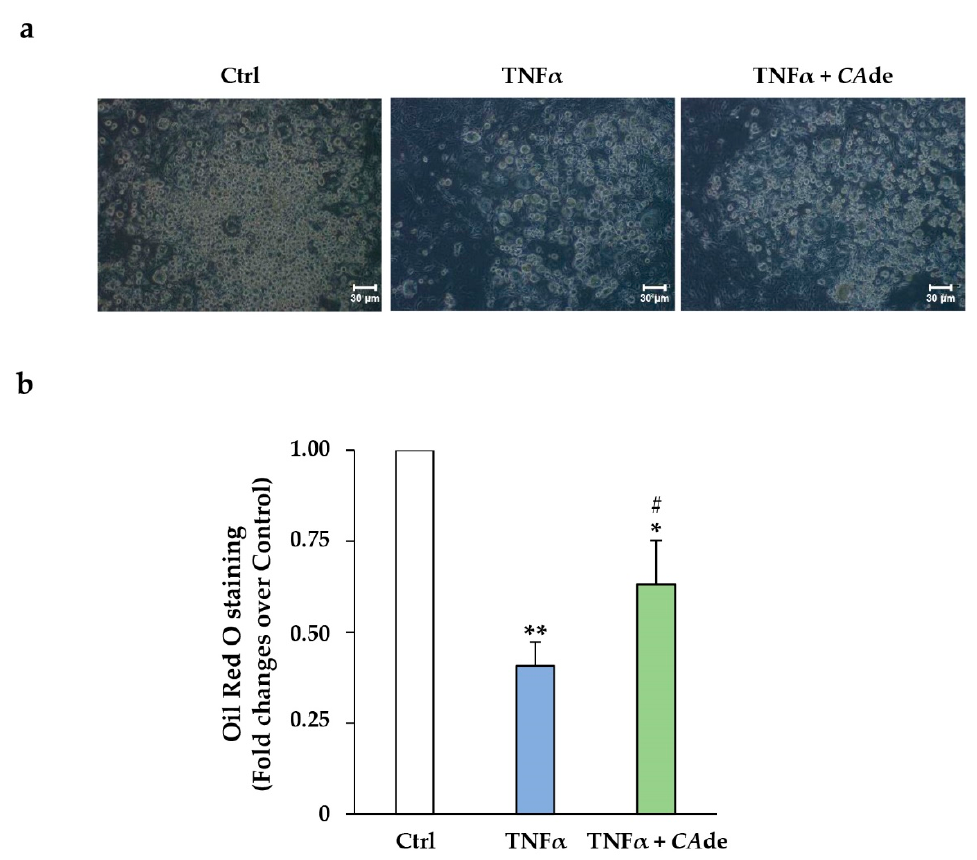
Figure 4. Effect of CA de on adipocyte differentiation and lipid accumulation of 3T3-L1 adipocytes treated with tumor necrosis factor-alpha (TNF α ). 3T3-L1 pre-adipocytes were cultured to reach adipocyte differentiation for 8 days with AS (Ctrl) or AS supplemented with TNF α (1 ng/mL) ± CA de (100 μ g/mL). ( a ) Representative microphotographs of Ctrl, TNF α -, and TNF α + CA de-treated adipocytes are shown (X10 magnifications); scale bars, 30 μ m. ( b ) Oil-Red O staining of Ctrl, TNF α -, and TNF α + CA de-treated adipocytes. Values are mean ± SEM of determinations from three independent experiments. Statistical significances among groups were tested by one-way ANOVA followed by Bonferroni correction post-hoc test. (* p < 0.05, and ** p < 0.01 vs. Ctrl; # p < 0.05, TNF α + CA de vs. TNF α ).